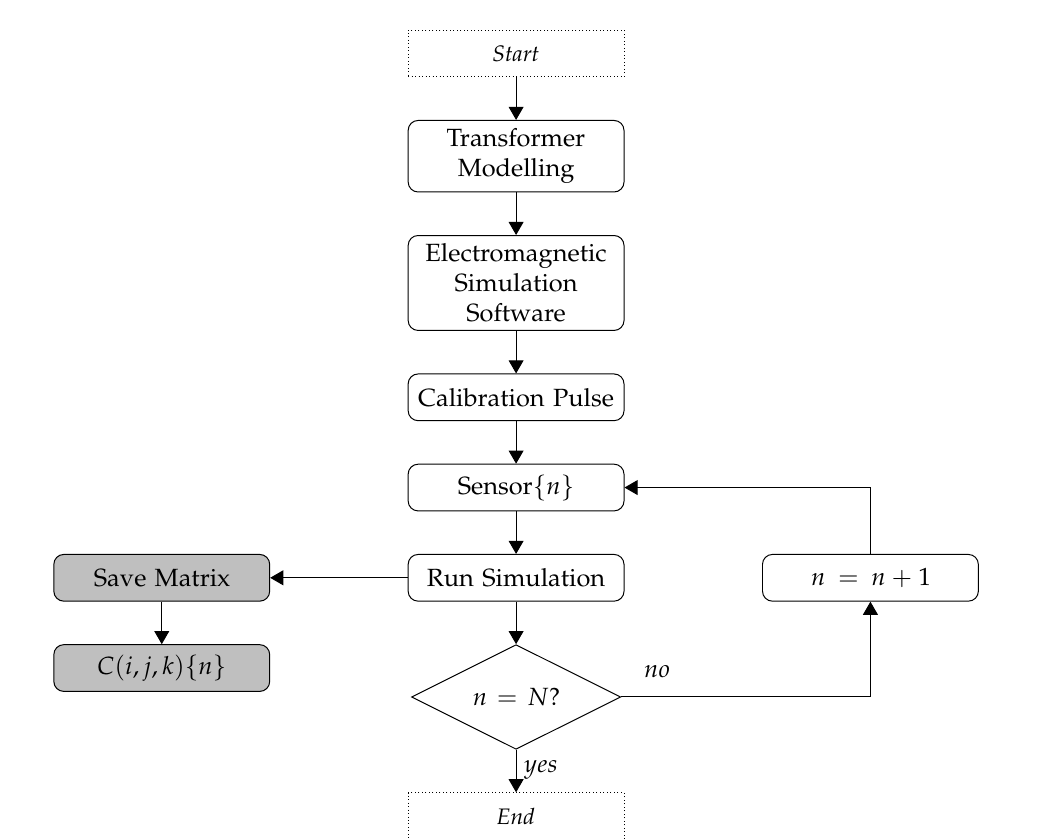
Figure 3. Flowchart of the proposed methodology to obtain the transformer propagation